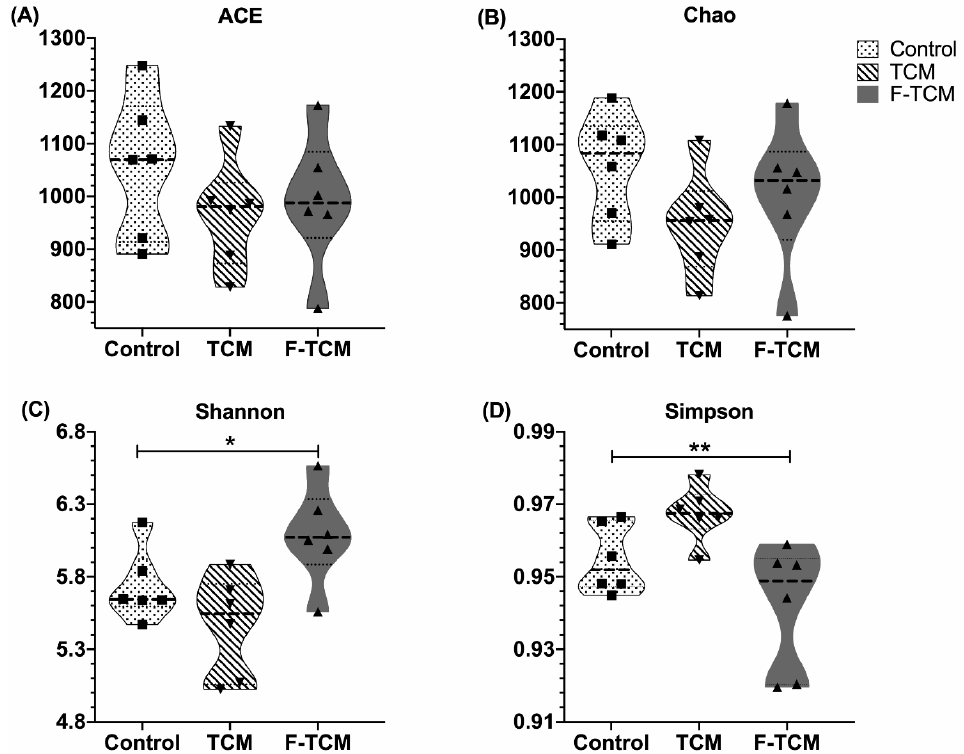
Figure 1. The richness and diversity of the fecal microbiota in weaned piglets. ( A ) ACE index, ( B ) Chao index, ( C ) Shannon index, ( D ) Simpson index; * indicate significant differences among three groups ( p < 0.05), ** indicate significant differences among three groups ( p < 0.01) . The OTU distribution of the microbial communities of the different treatment groups had a certain degree of similarity and specificity. In order to understand the species dif- ferences, Venn diagrams were used to show the common and unique information among the different groups based on the OTU abundance information of the samples. As shown in Figure 2, 549 microbial species were common to all groups; however, 101 OTUs were unique in the control, and 136 and 146 OTUs were unique in the TCM and F-TCM groups, respectively.